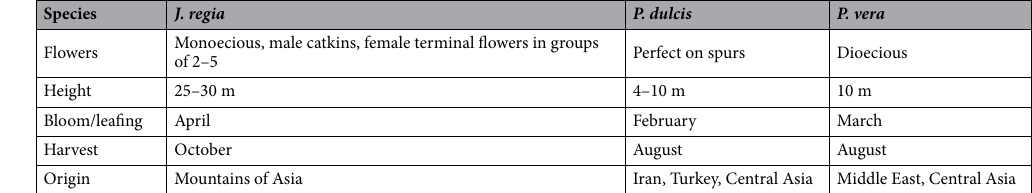
Table 1. Botany, phenology and origin of J. regia , P. dulcis , and P.